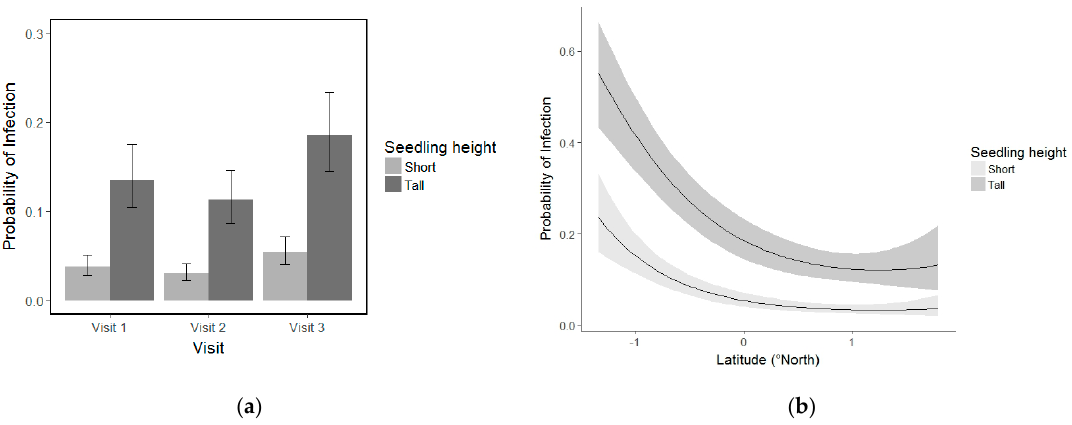
Figure 8. Probability of seedling infection by white pine blister rust for short (<50 cm) and tall (>50 cm) seedlings by year ( a ) and latitude ( b ). Plots were constructed using the range of values for visit ( a ) and latitude ( b ) while holding remaining predictor variables at their mean values for the study area. Confidence intervals (alpha = 0.05) are shown.